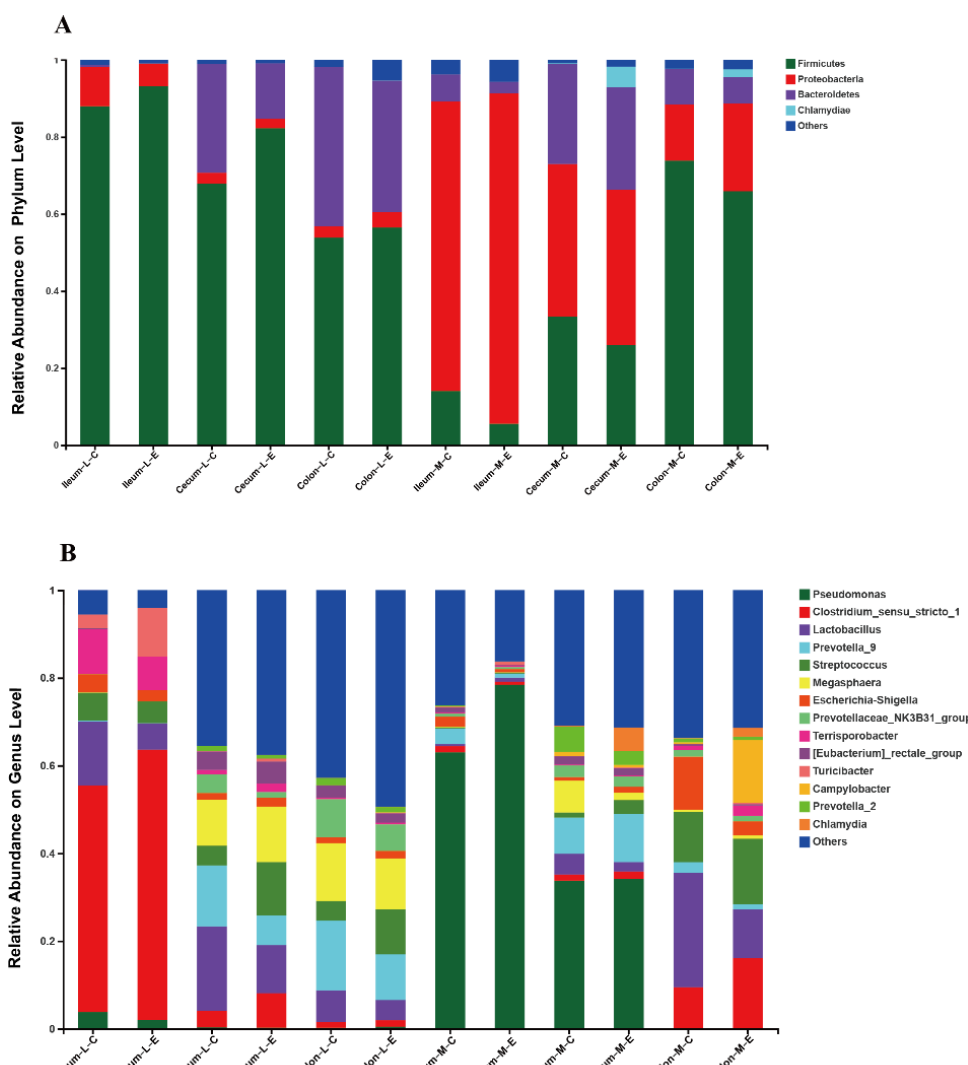
Figure 4. Microbiota composition in different niches. ( A ) Relative abundance of bacterial taxa on the phylum level. ( B ) Relative abundance of bacterial taxa on the genus level. Only phylum with average relative abundance greater than 1% and genus greater than 5% were shown. L, lumen contents; M, mucosa; C, control; E, Enterococcus faecium HDRsEf1.